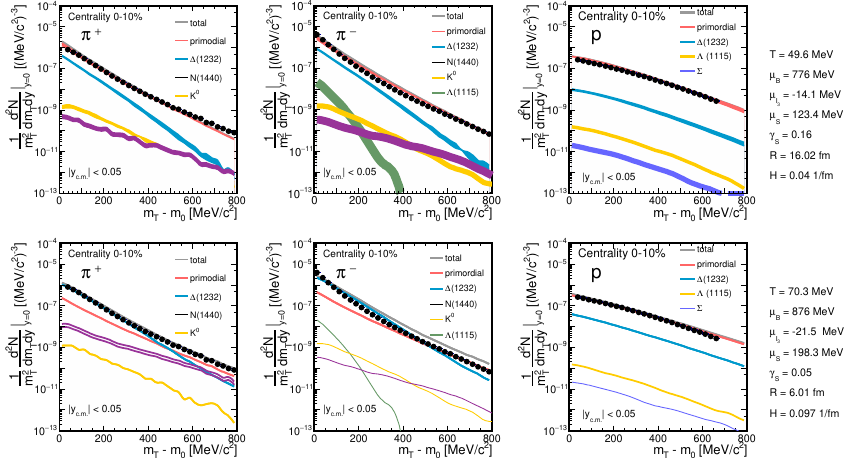
Figure 3. Transverse mass distributions of p and π ± at mid-rapidity, measured by HADES, compared to thermal model calculations with parameters from [11] (upper row) and from [12], corresponding to the same way of treating nuclear clusters, but to the higher-temperature minimum of the thermal fit (lower row, for details see text and the reference). The respective values of the parameters are also Figure 1. Transverse mass distributions of π − (left panel) and π + (right panel) at mid-rapidity, measured by HADES [4] overlaid with contribution from decays of ∆ (1232), calculated with mass distribution from [10] (blue solid curves) and with zero width at nominal mass (blue dashed curves).